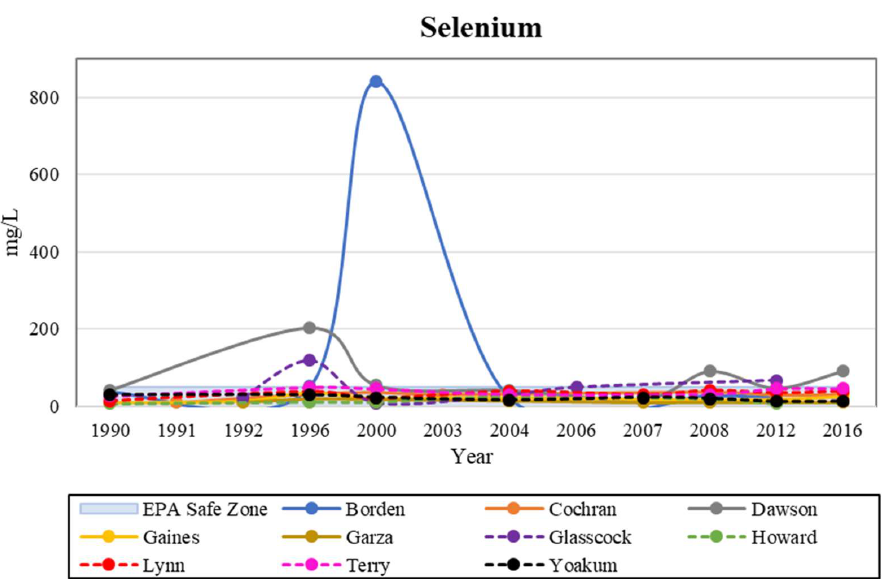
Figure 9. Historical analysis of Selenium levels in the study area, with the EPA safe zone shown for comparison.